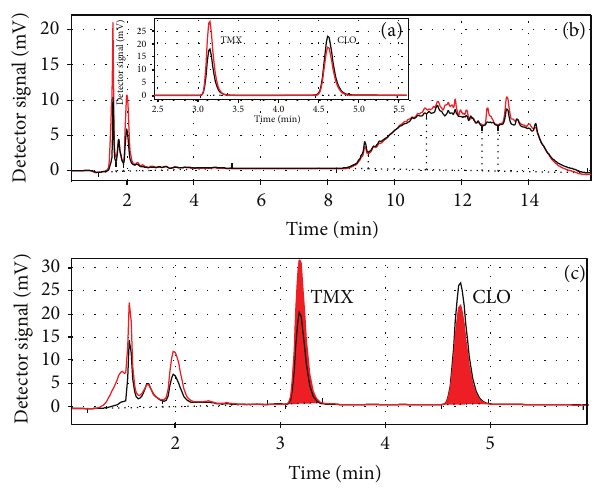
Figure 2: Chromatograms of a standard solution of CLO and TMX at 2.50 𝜇 g/mL (a), a blank clay sample (b), and the same clay sample spiked with CLO and TMX at 1.0 𝜇 g/g (c). Chromatograms were recorded at 269 nm (Channel 1, black line) and at 252 nm (Channel 2, red line). Retention times were 3.17 and 4.65 min for TMX and CLO,